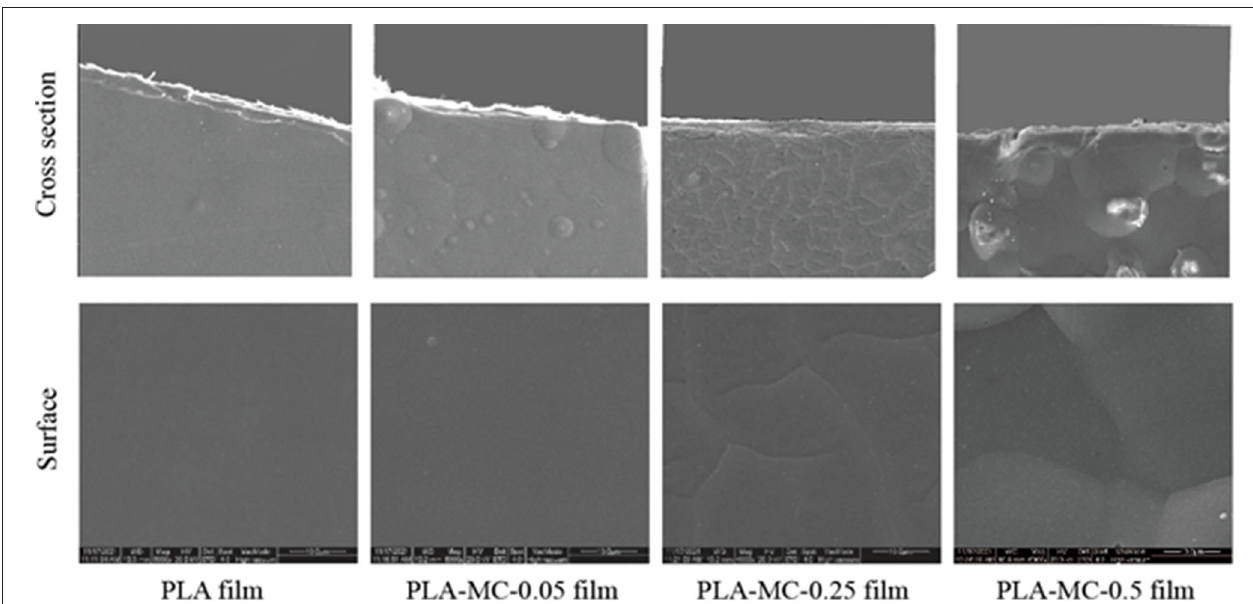
FIGURE 2 | Surfaces (lower row) and cross sections (upper row) of the PLA and PLA–MC films under scanning electron microscopy (SEM), scale bar = 10 µ